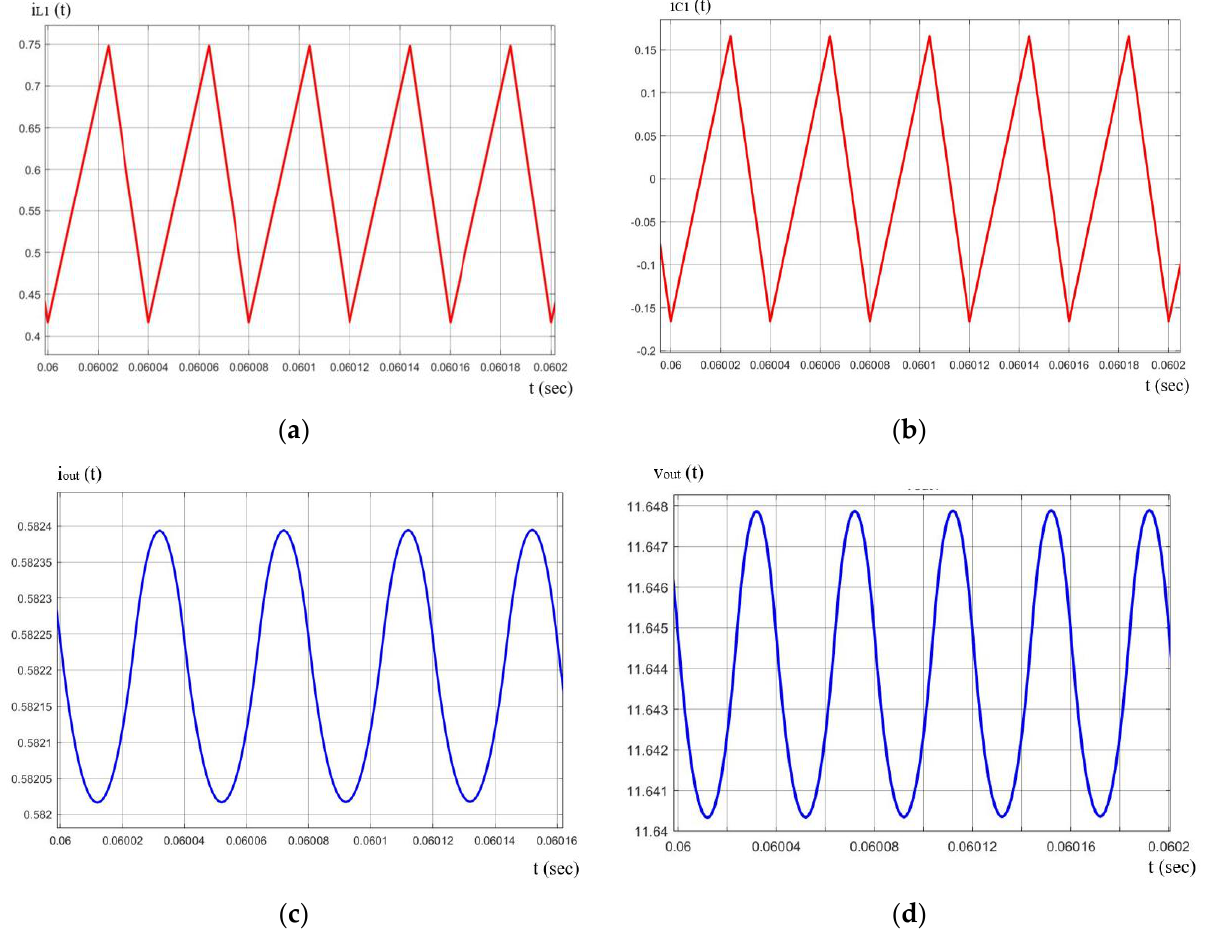
Figure 5. Measured quantities: ( a ) current on the inductor; ( b ) current on the capacitor; ( c ) output current; ( d ) output voltage.